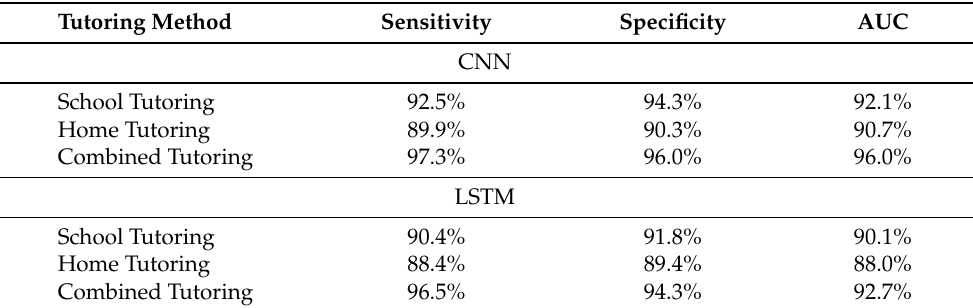
Table 4. Performance of deep neural network models when used with Improved